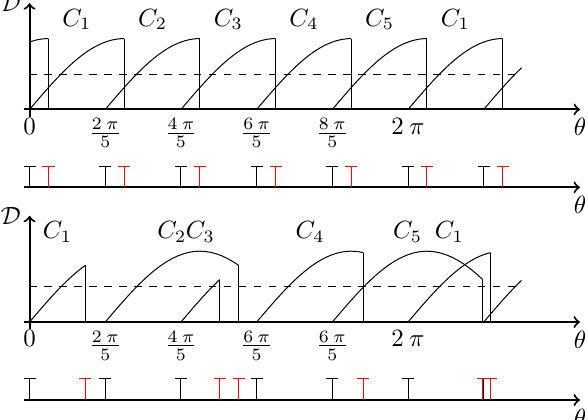
Figure 8: Flow/torque output response and control de- cision scheme of a partial stroke operated DDM, using only motoring